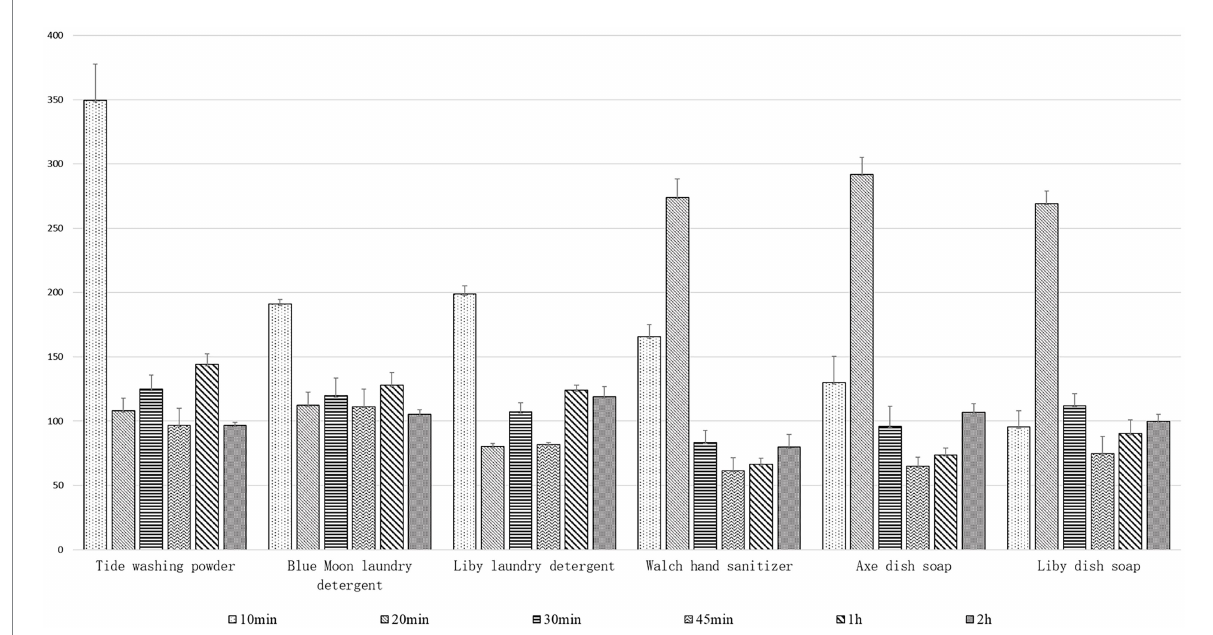
FIGURE 6 Immersion resistance of the recombinant Lip54q to six common commercial detergents. Six detergents used in the test include Tide washing powder, Blue Moon laundry detergent, Liby laundry detergent, Walch hand sanitizer, Axe dish soap, and Liby dish soap. By using a standard of 10 g of detergent per kilogram of clothing and soaking in 5 l of tap water, six detergents were added to tap water. After mixing, 0.5 ml (10 U) of enzyme solution was added to each experimental group and treated for 10, 20, 30, 45, 60, and 120 min. Then, the residual enzymatic activities were determined under standard conditions. The enzymatic activity of the pure enzyme solution without detergent was defined as 100%, and the relative enzyme activities treated with each detergent were calculated. Data points are the average of triplicate experiments, and error bars represent standard deviation.